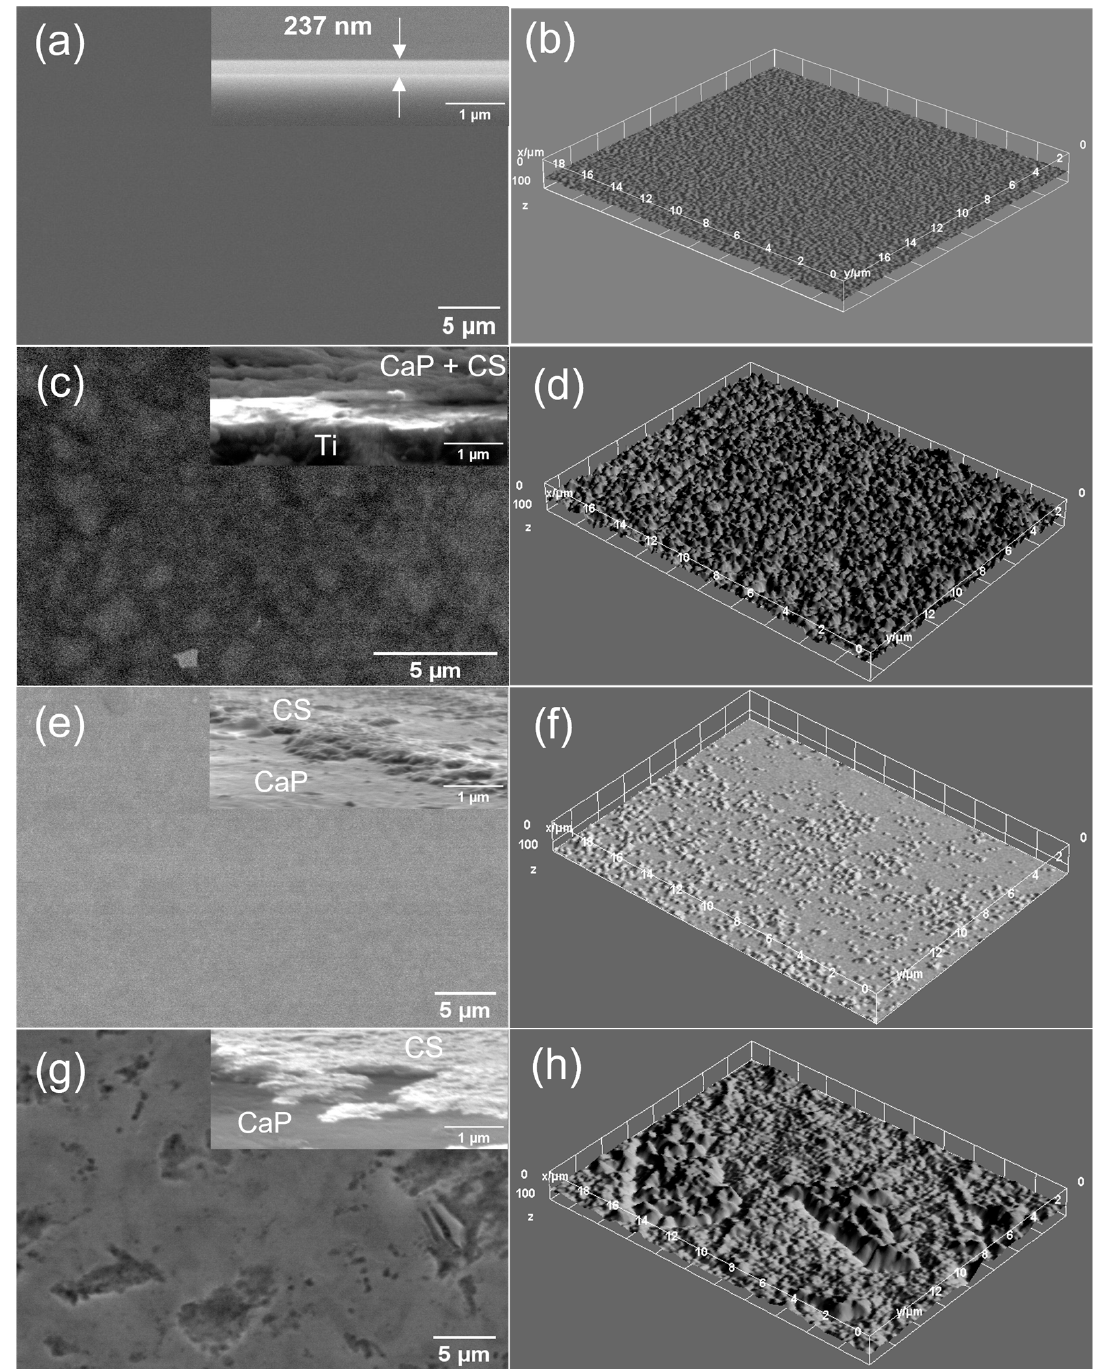
Figure 15. SEM images of ( a ) chitosan deposited on Si by MAPLE, ( c ) CaP_1_CS, ( e ) CaP_2_CS, and ( g ) CaP_3_CS samples. 3D surface plots of ( b ) chitosan deposited on Si by MAPLE, ( d ) CaP_1_CS, (f ) CaP_2_CS, and ( h ) CaP_3_CS samples.